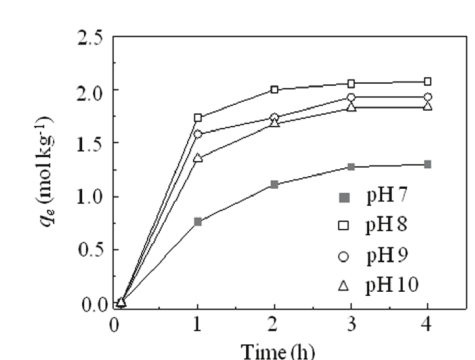
Fig. 4 – Effect of initial pH value on the uptake of D-GA